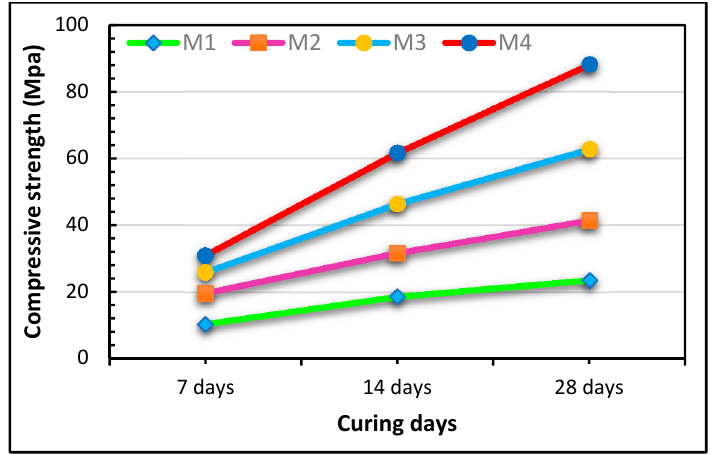
Figure 19. Compressive strength of various IW3 cement replacements on various curing days [253].